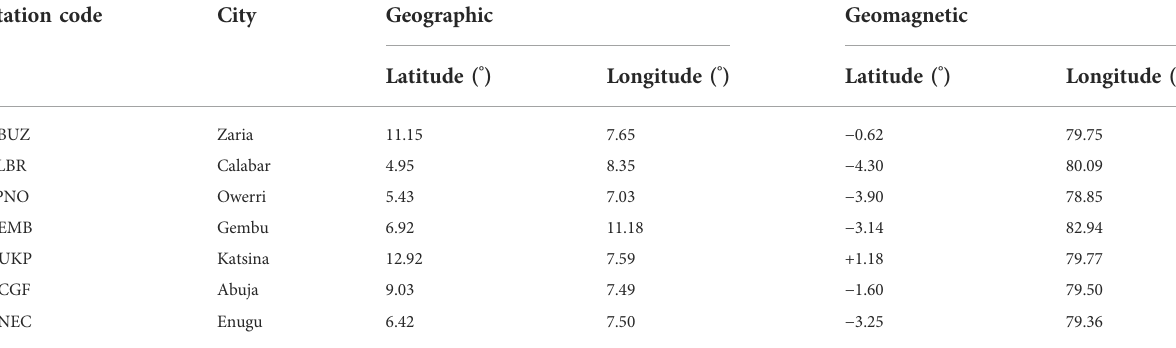
TABLE 1 NIGNET receiver stations. The latitudes are positive for north and negative for south, while the longitudes are positive for east. Station code